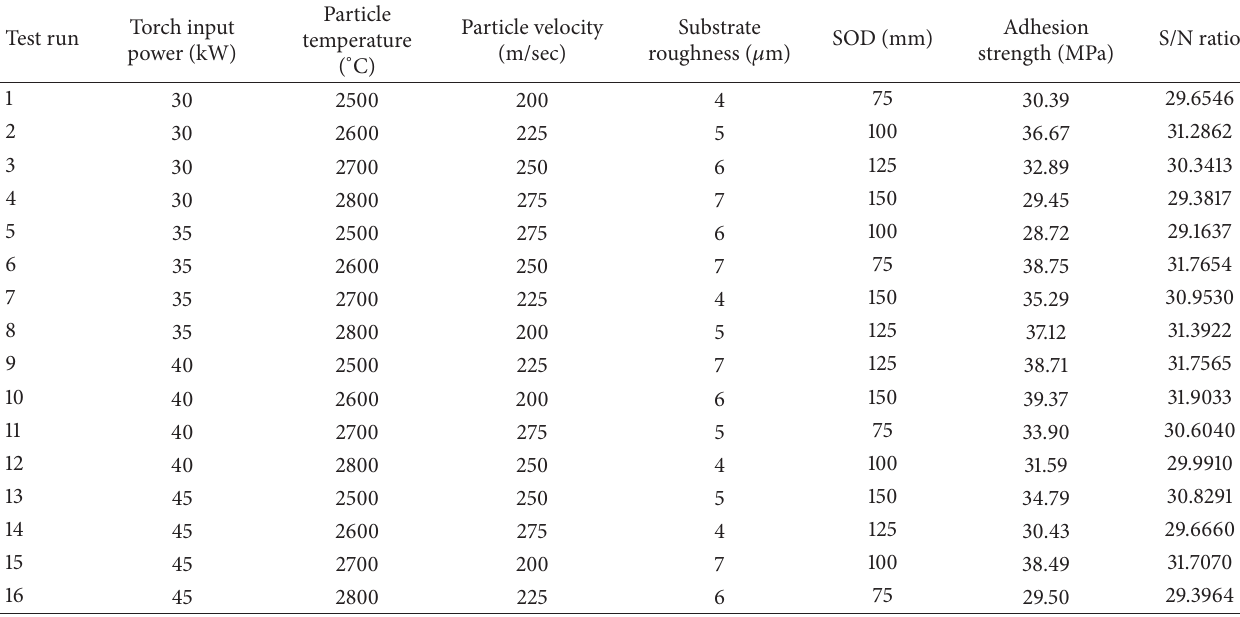
Table 3: L Orthogonal array design with output and S/N ratio. 16